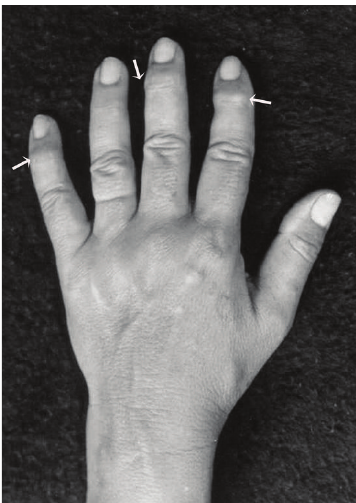
Figure 1: Bony growth spurs at the joint at the end of the fingers— Heberden’s nodes (arrows).